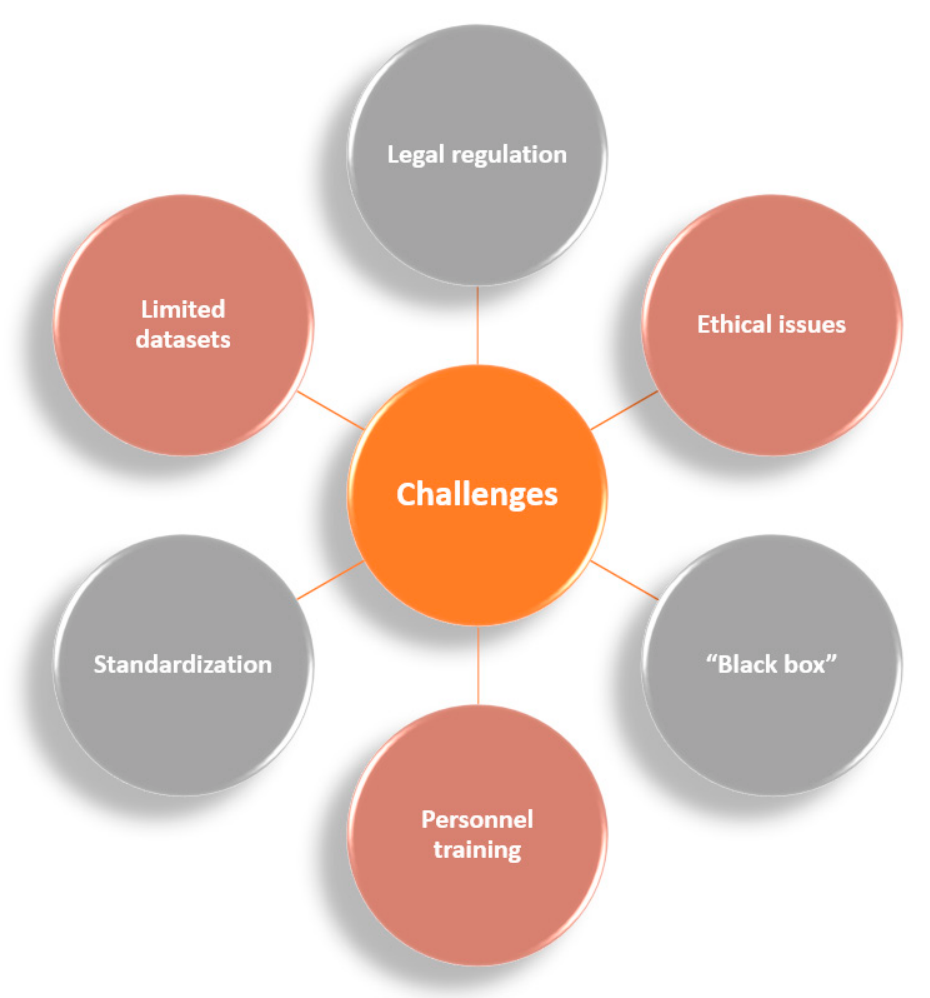
Figure 5. The main challenges in AI clinical integration.